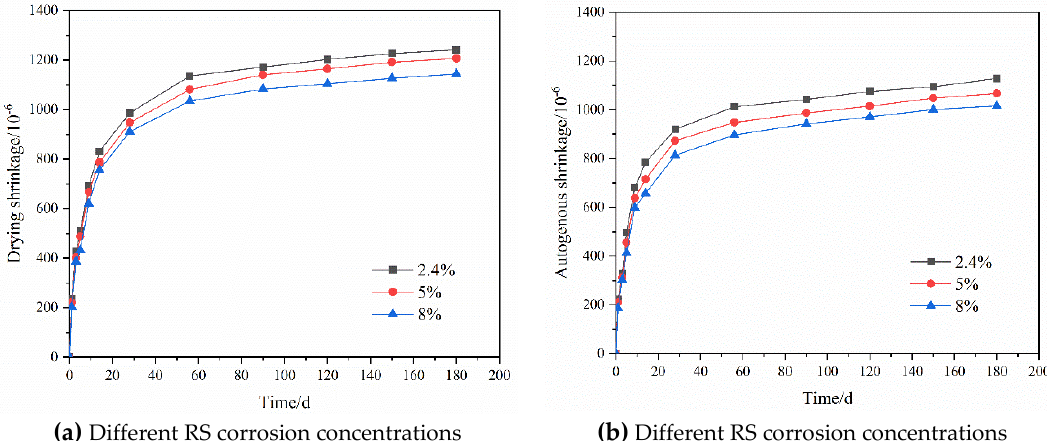
Figure 5. Effect of the RS erosion concentration on the shrinkage of mortar: (a ) Drying shrinkage; ( b ) Autogenous shrinkage.